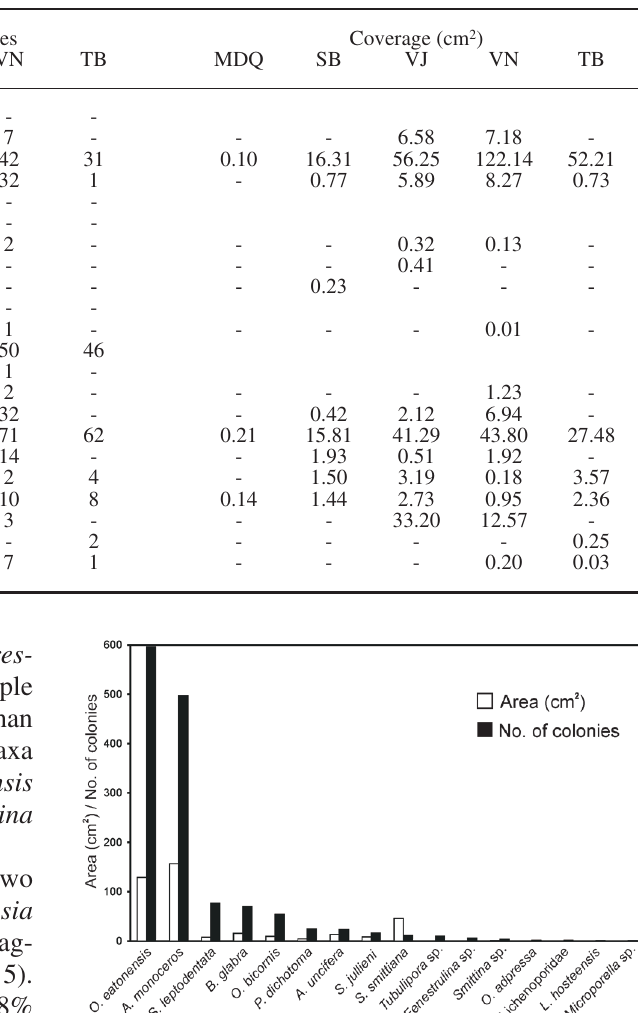
Table 3. – Percent of colonised valves and coverage of 22 bryozoan taxa growing on Psychrochlamys patagonica . The area was not measured in runner-like or erect colonies. MDQ: MDQ, SB: San Blás, VJ: Valdés January, VN: Valdés November, TB: Tango B.